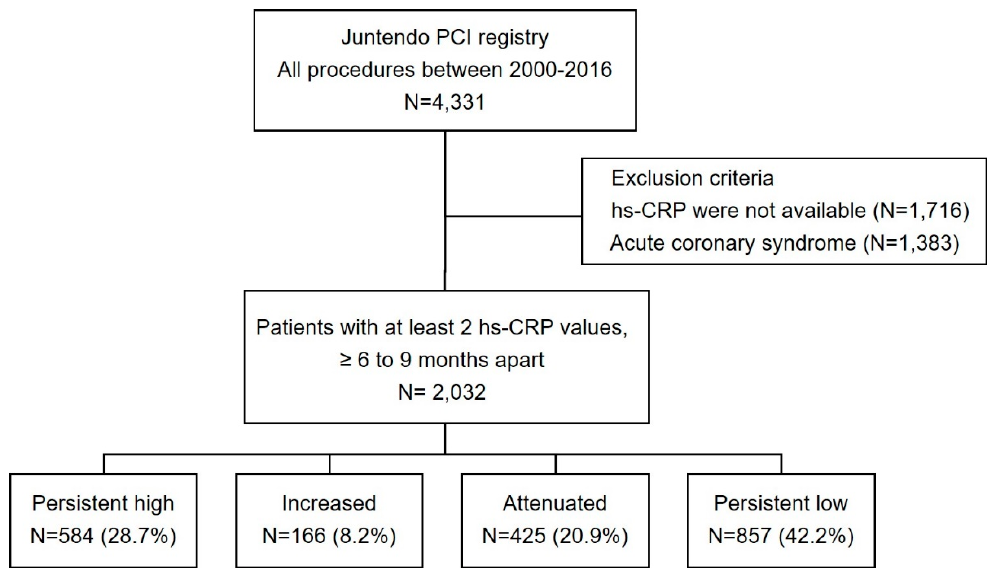
Figure 1. Study flow chart. PCI, percutaneous coronary intervention; hs-CRP, high-sensitivity C-reactive protein; ACS, acute coronary syndrome; RIR, residual inflammatory